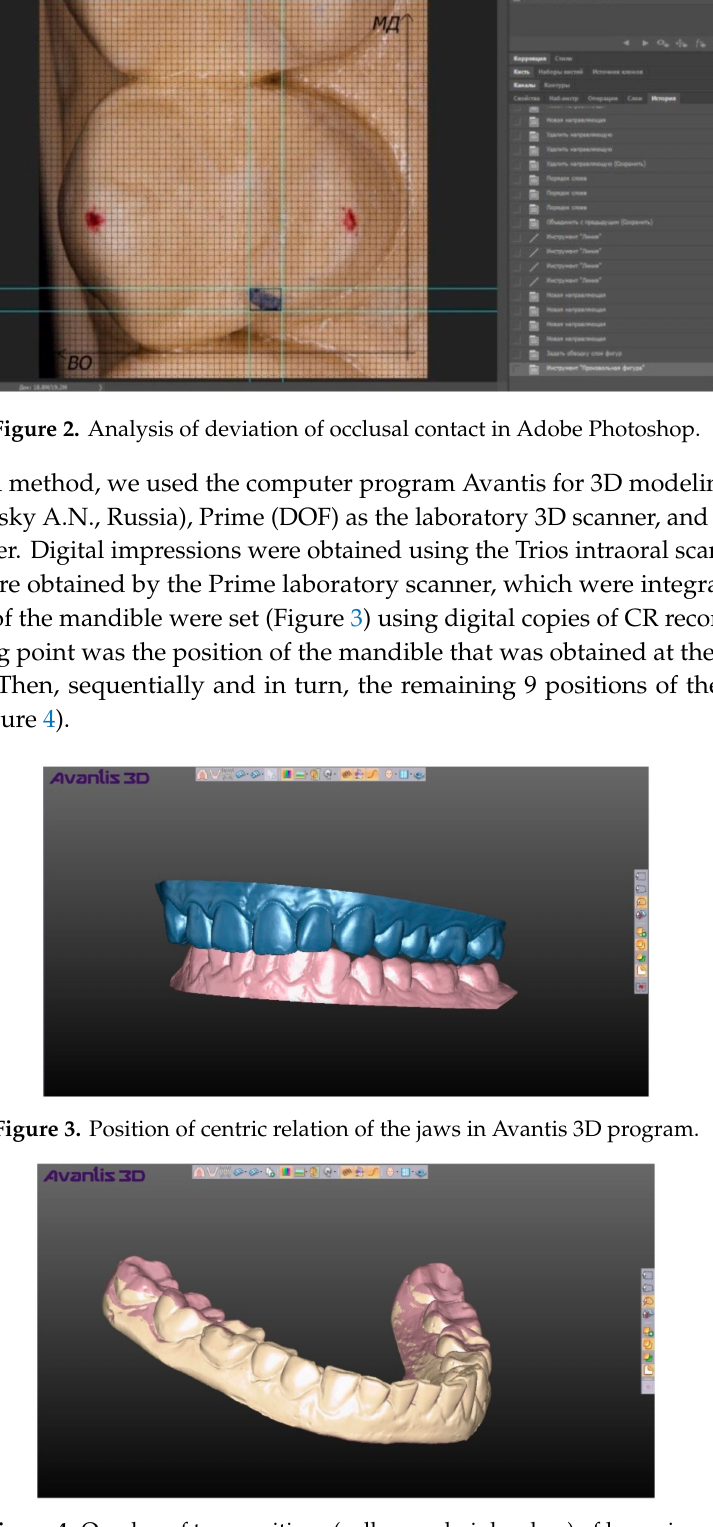
Figure 4. Overlap of two positions (yellow and pink colors) of lower